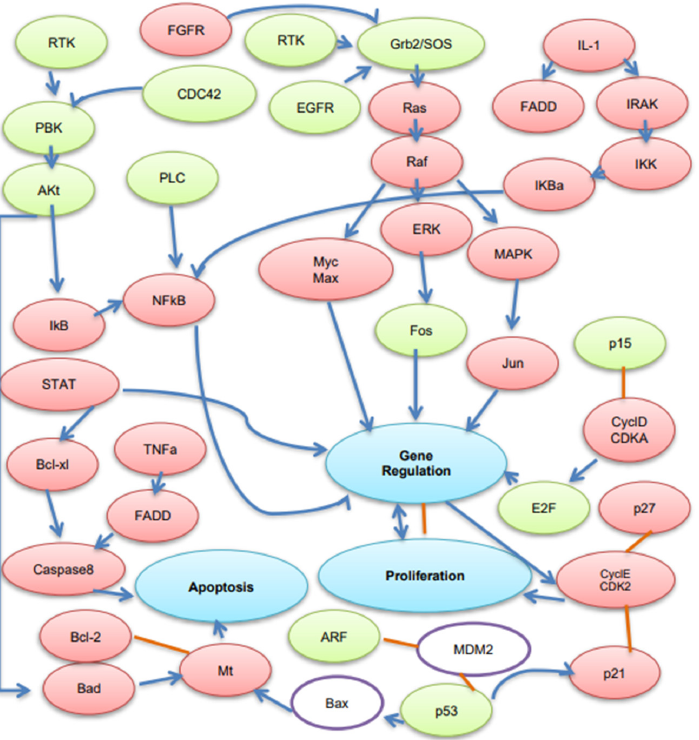
Figure 4. Biological pathways related to cell proliferation based on our results. Red denotes upregu- lated genes and green denotes downregulated genes. MDM2 and Bax (purple circles) were listed in published studies but were not among our detected DEGs. An arrow pointing (blue lines) signifies activation (e.g., binding, phosphorylation); orange lines signify direct protein